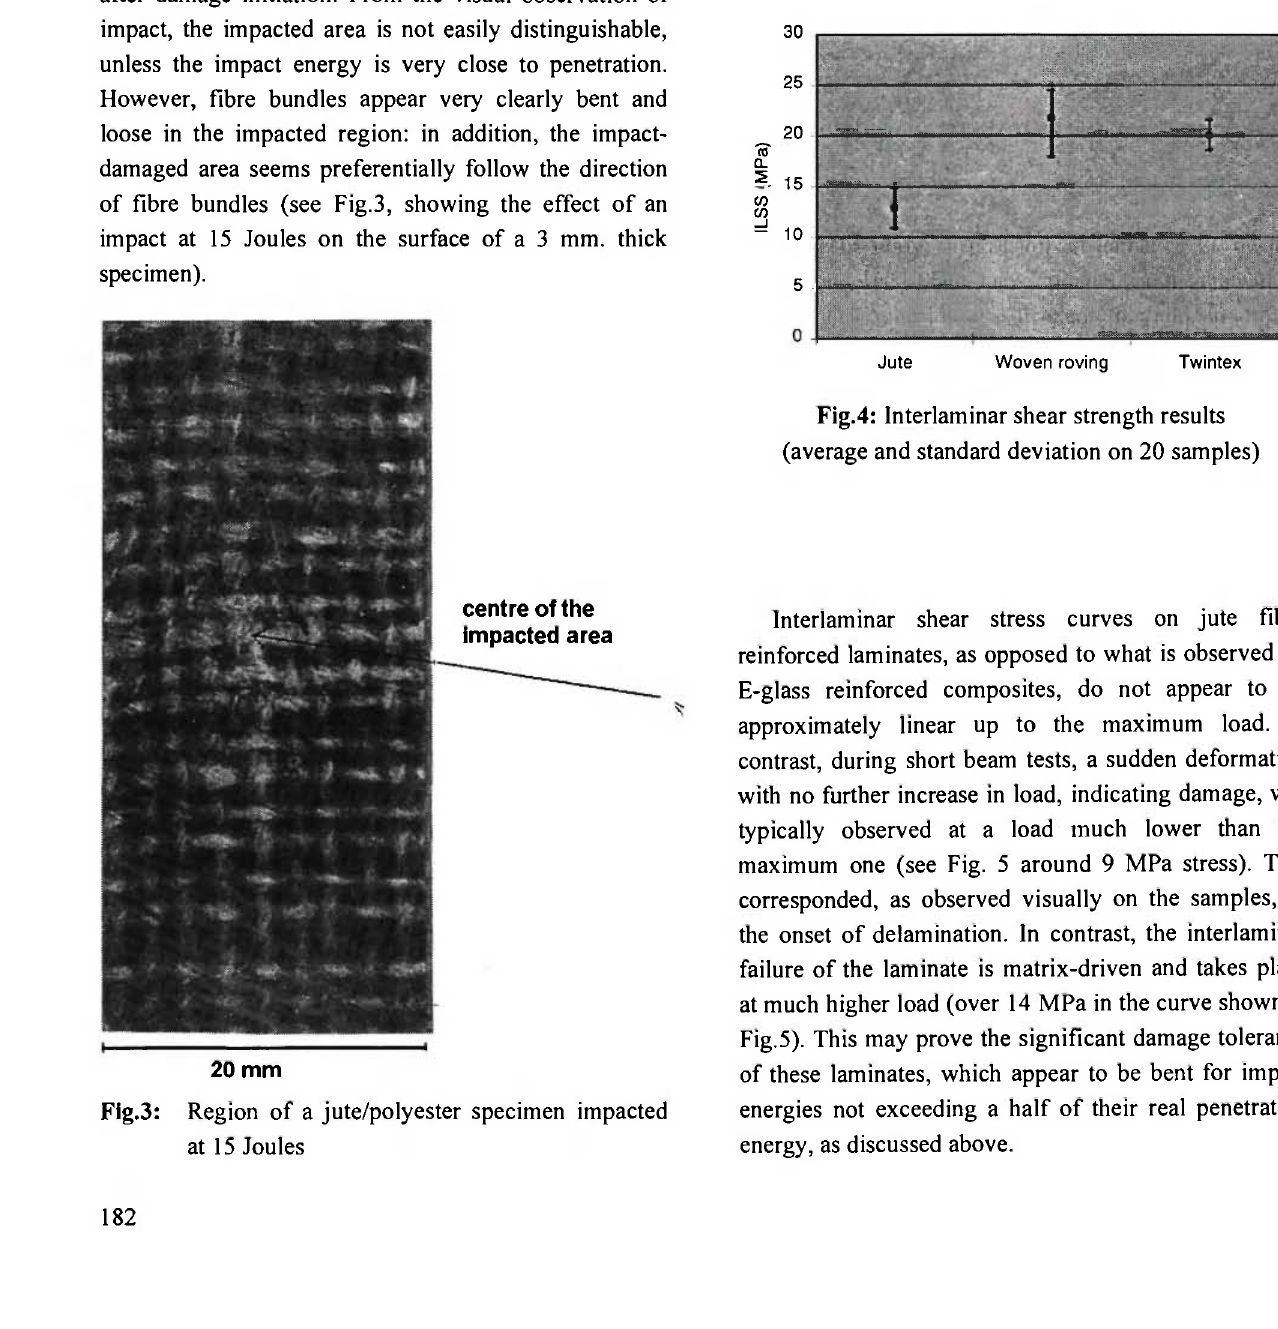
Interlaminar curves